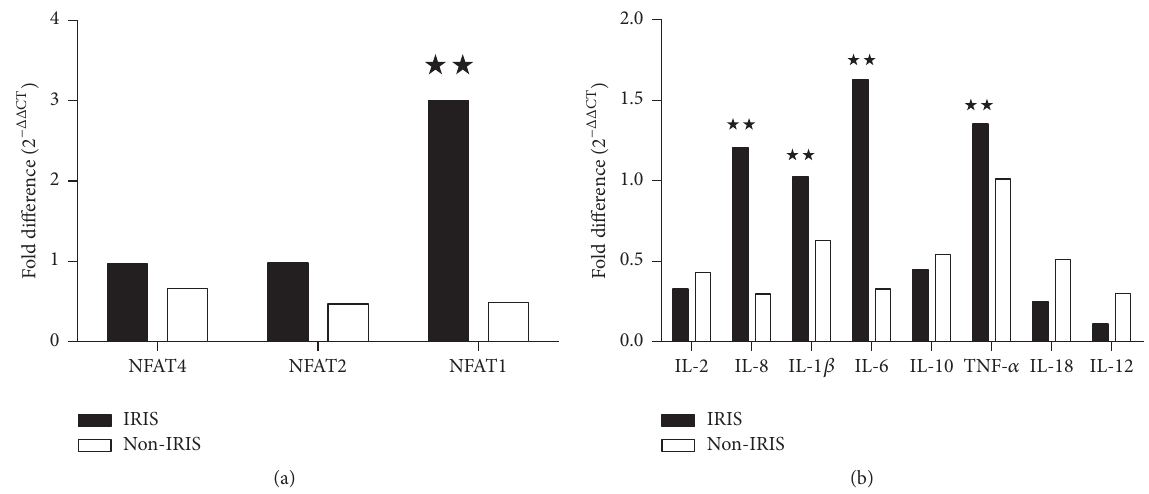
Figure 1: NFAT and cytokine gene relative expression levels compared before and after HAART in the immune reconstitution inflammatory syndrome (IRIS) and non-IRIS groups of AIDS patients. (a) NFAT expression in IRIS groups before and after HAART; NFAT1 expression from low to high after HAART; the relative expression of mRNA for NFAT1 gene to GAPDH after HAART was 3.002-fold higher as compared to that before HAART. (b) Cytokine gene expression in IRIS groups before and after HAART; IL-1 𝛽 , IL-6, IL-8, and TNF- 𝛼 expression from low to high; TNF- 𝛼 gene expression also increased in non-IRIS group after HAART; ‰‰ the gene expressions after HAART were higher than those before treatment.